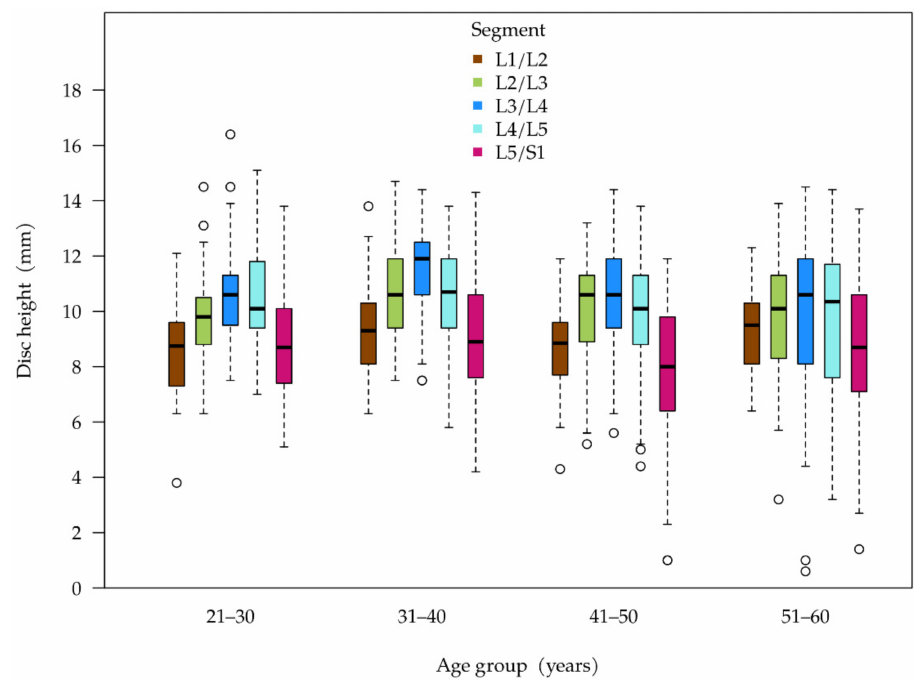
Figure 3. Disc height in mm per segment and age cohort.